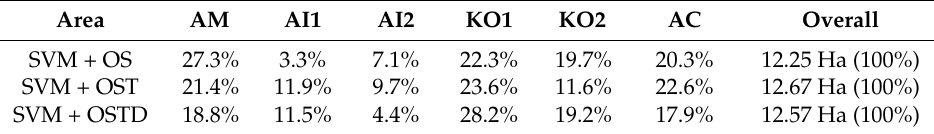
Table 7. Class area statistics for SVM classifiers with different features.